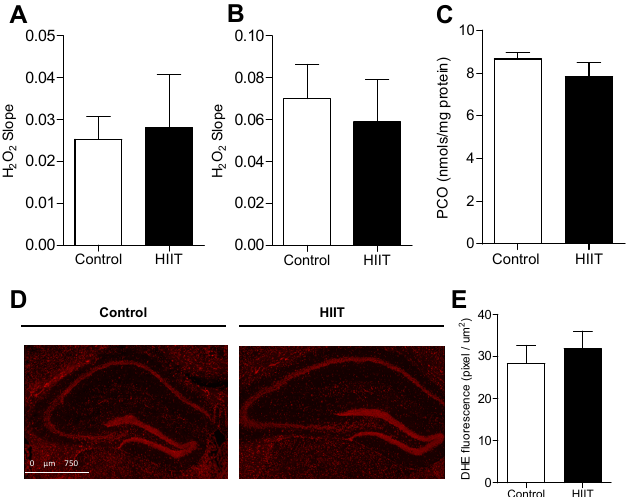
Figure 4. Effect of one-week HIIT on redox parameters in the hippocampus and dentate gyrus. ( A ) H 2 O 2 production in the hippocampus and ( B ) cerebral cortex (control n = 3; HIIT n = 3); ( C ) carbonylated protein concentration in the hippocampus (control n = 4; HIIT n = 4); ( D ) DHE fluorescence—superoxide anion; ( E ) superoxide anion level in the dentate gyrus (control n = 4; HIIT n = 4); Slope: variation rate of UF/time, normalized by protein content (UF: fluorescence units). Statistical analyses were performed by the Student’s t -test using p < 0.05.